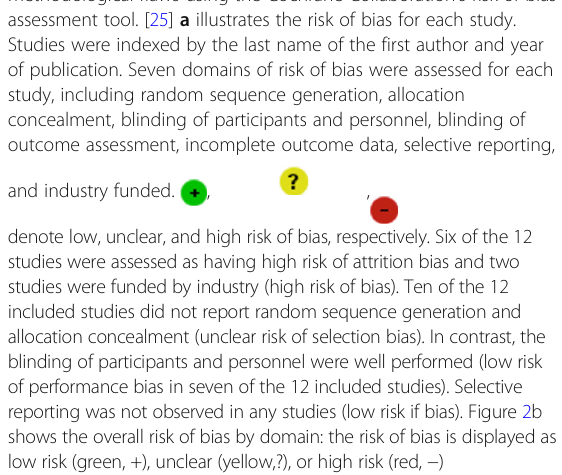
Fig. 2 a - b . Risk of Bias Assessment Using Cochrane the Collaboration ’ s Tool. The included studies were evaluated for methodological flaws using the Cochrane Collaboration ’ s risk of bias assessment tool. [25] a illustrates the risk of bias for each study. Studies were indexed by the last name of the first author and year of publication. Seven domains of risk of bias were assessed for each study, including random sequence generation, allocation concealment, blinding of participants and personnel, blinding of outcome assessment, incomplete outcome data, selective reporting, and industry